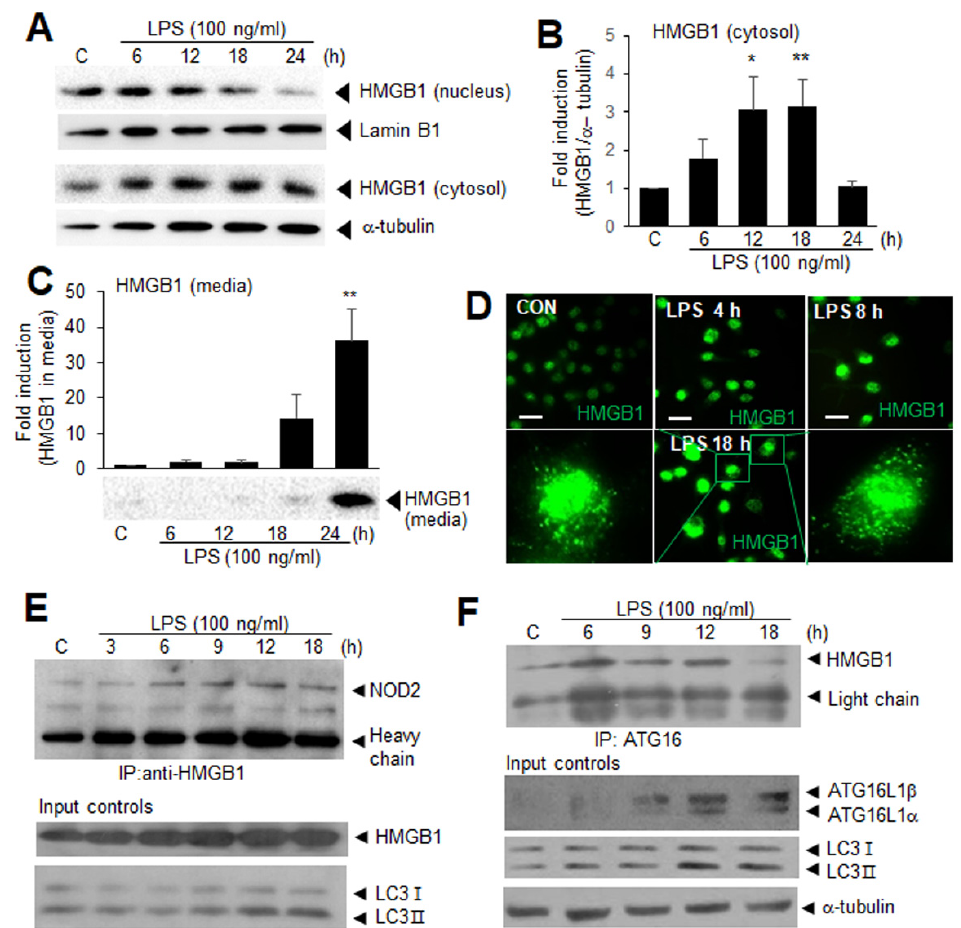
Figure 3. Cytosolic HMGB1 translocated from the nucleus after LPS treatment interacts with NOD2 and ATG16 in BV2 cells. ( A , B ) BV2 cells were treated with LPS (100 ng/mL), and the levels of HMGB1 in nucleus and cytosol were examined after 6, 12, 18, and 24 h of LPS treatment using immunoblotting. Representative immunoblots are presented in ( A ) and quantification results of cytosolic is presented as the mean ± SEM ( n = 4) in ( B ); ( C ) BV2 cells were treated with LPS (100 ng/mL), and the levels of HMGB1 in culture medium were examined after 6, 12, 18, and 24 h of LPS treatment using immunoblotting. Representative immunoblots are presented and quantification result is presented as the mean ± SEM ( n = 6); ( D ) Immunofluorescence staining was carried out at 4, 8, and 18 h after LPS treatment with the anti-LC3 antibody, and representative images at each time point and high magnification images obtained from 18 h are presented. Scale bar, 50 μ m; ( E , F ) BV2 cells were treated with LPS (100 ng/mL) for 3, 6, 9, 12, and 18 h, and the interactions between HMGB1-NOD2 ( E ) or HMGB1-ATG16 ( F ) were examined using co-immunoprecipitation. Antibodies used in immunoprecipitation and immunoblotting are presented in each experiment. * p < 0.05, ** p < 0.01 vs. PBS-treated control cells.